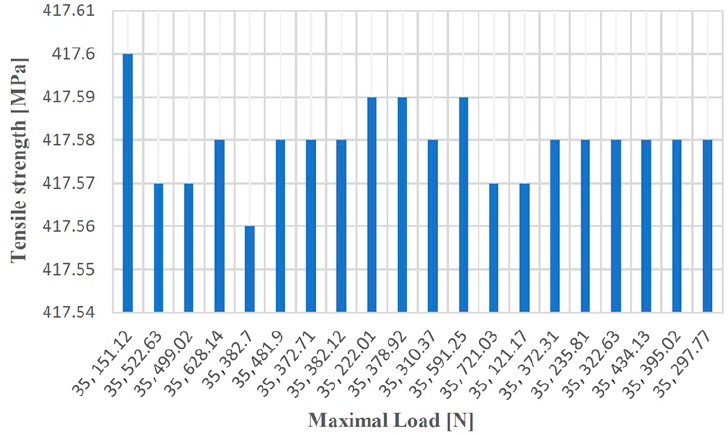
Figure 12. Values of the tensile strength according to the maximum forces applied to the 20 samples made of cast iron with spheroidal graphite type EN-GJS-400-15.